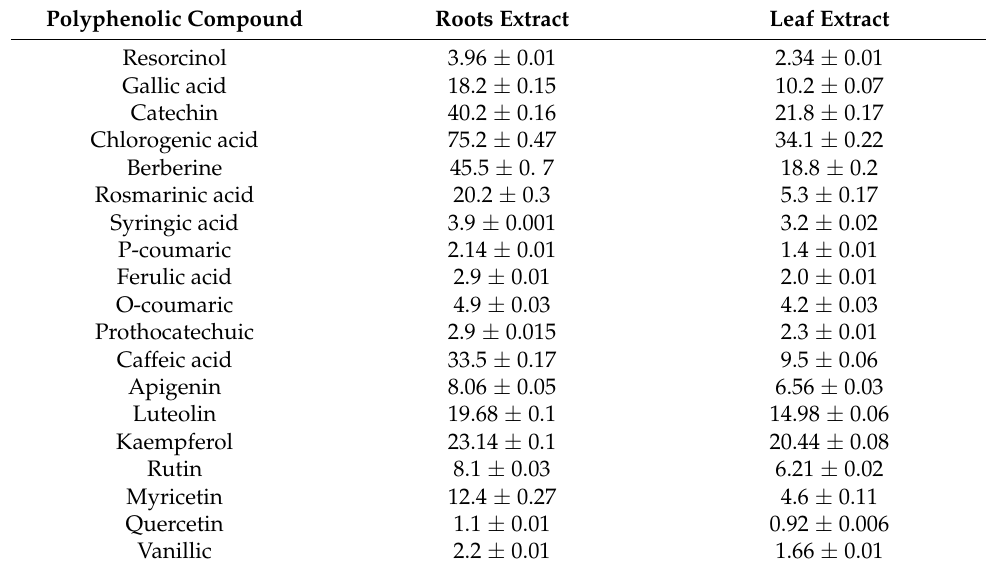
Figure 1. HPLC-chromatograms of polyphenolic compounds detected in Berberis vulgaris root and leaves. Table 2. Phenolic and flavonoids concentration in Berberis vulgaris roots and leaves extracts as (mg/mL